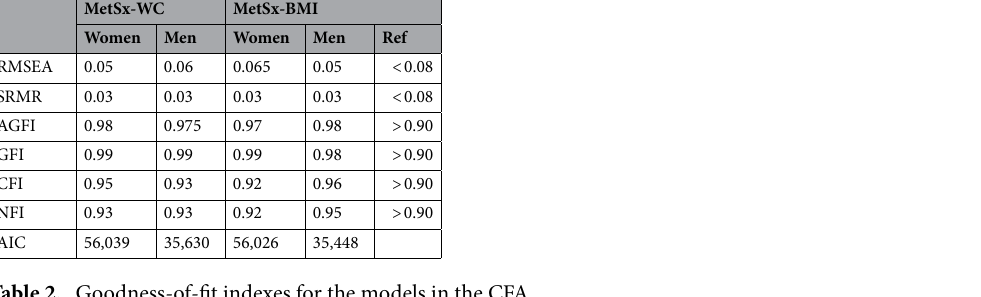
Table 2. Goodness-of-fit indexes for the models in the